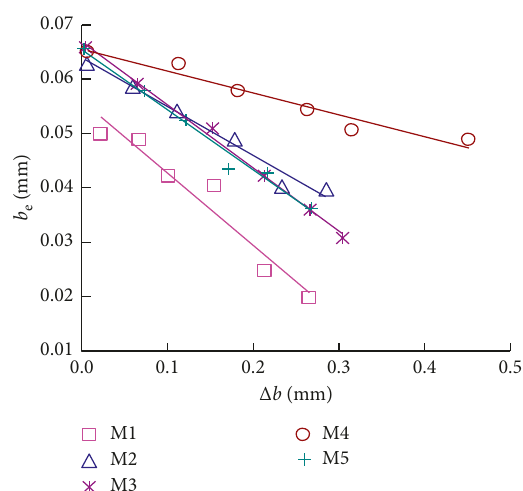
Figure 3: Relationships between equivalent hydraulic aperture and fracture closure.